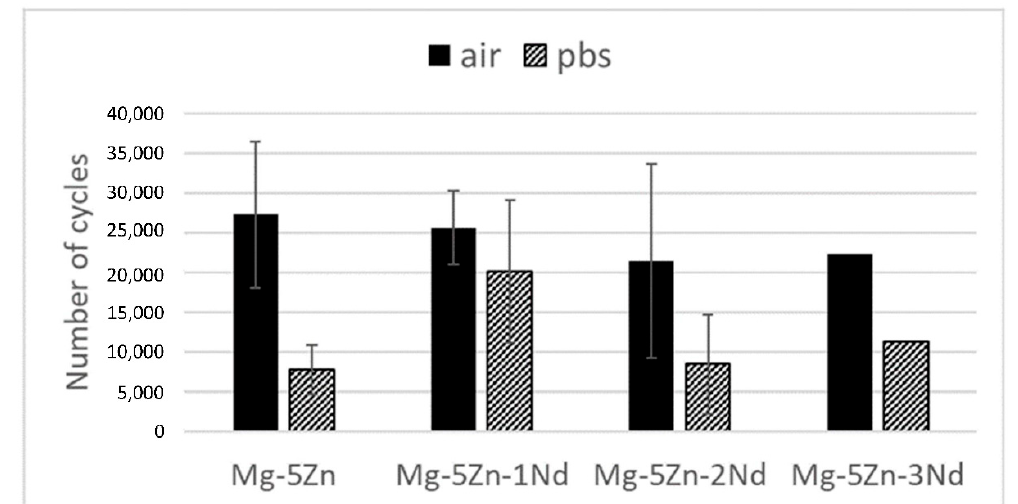
Figure 8. The life span of the tested alloys under low cycle fatigue conditions as obtained in air and the PBS solution.